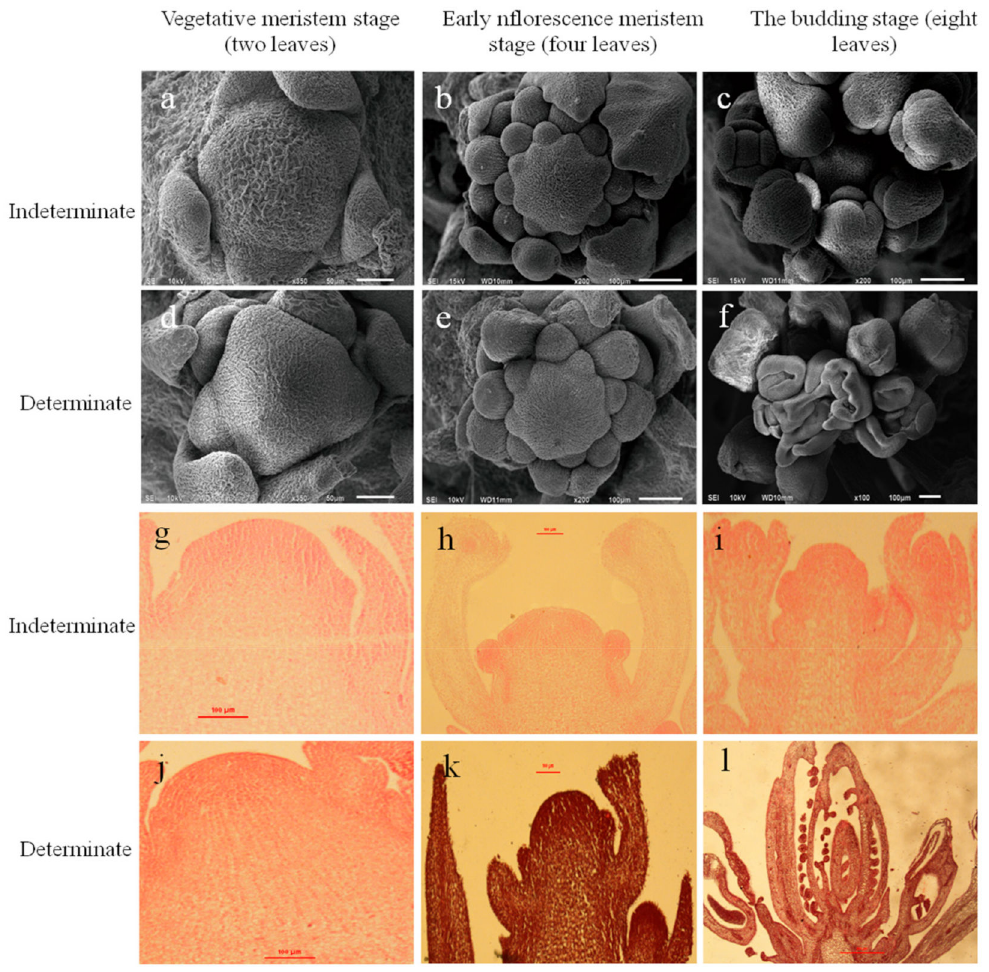
Figure 1. Scanning electron microscopy and para ffi n section images of indeterminate ( a–c,g–i ) and determinate ( d–f , j–l ) shoot apical meristems (SAMs). ( a , d , g , j ) SAMs of indeterminate and determinate inflorescences at the vegetative growth stage (two leaves). ( b , e , h , k ) SAMs of indeterminate and determinate inflorescences at the early inflorescence meristem stage (four leaves). ( c , f , i , l ) SAMs of indeterminate and determinate inflorescences during the budding period (eight